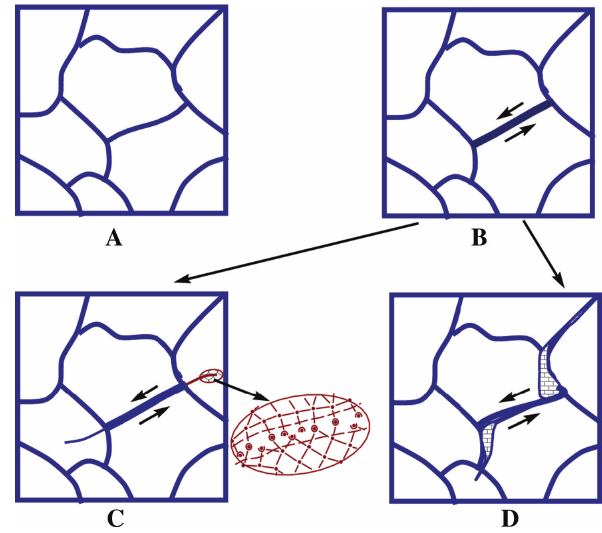
Figure 9 Stages of the plastic deformation of a polycluster. (A) Initial polycluster structure; cluster boundaries are shown. (B) Under external stress, a DLESZ is formed as a result of boundary layer sliding. This STZ is shown as bold line. The loop is blocked at triple joints of clusters. (C) DLESZ climbed into the neighbor- ing clusters. Inset, its microscopic structure. Noncoincident sites are marked by semicircles. (D) Nanocracks along the intercluster boundary are